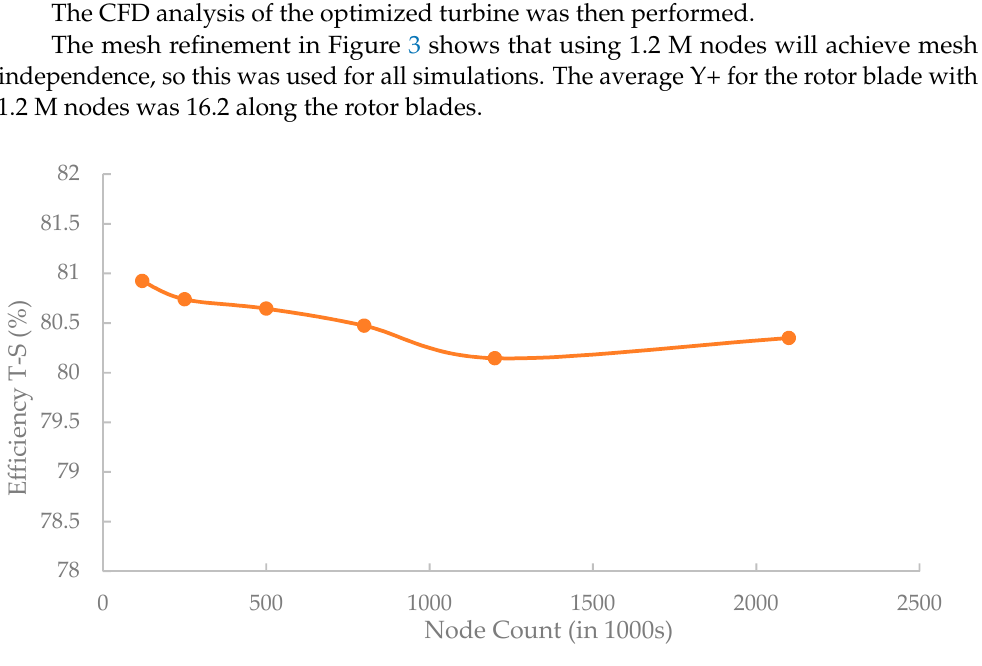
Figure 3. Mesh refinement study based on total-to-static efficiency evolution over number of nodes.